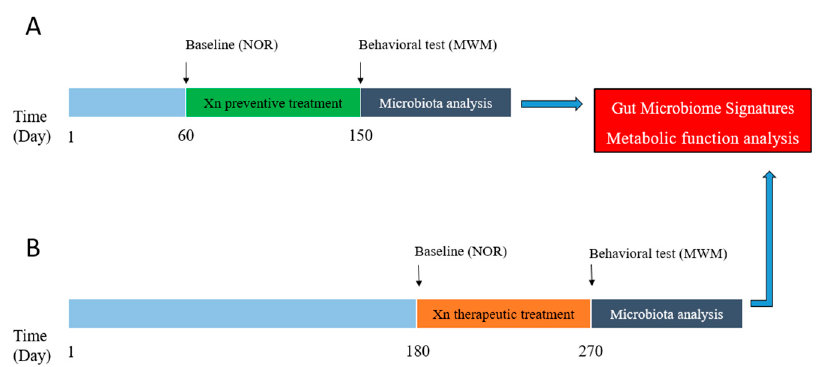
Figure 6. Schematic diagram of the experimental design. ( A ) Diagram depicting the prevention experiment. Before xanthohumol (Xn) administration at age of 60 days, novel object recognition (NOR) test in the baseline was detected. ( B ) Diagram depicting the therapy experiment. Before Xn administration at age of 180 day, NOR test in the baseline was also detected. Morris water maze (MWM) test and fecal samples for microbiota were detected after Xn administration for 3 months both in the prevention and therapy experiments. NOR, novel object recognition test. MWM, Morris water maze test.